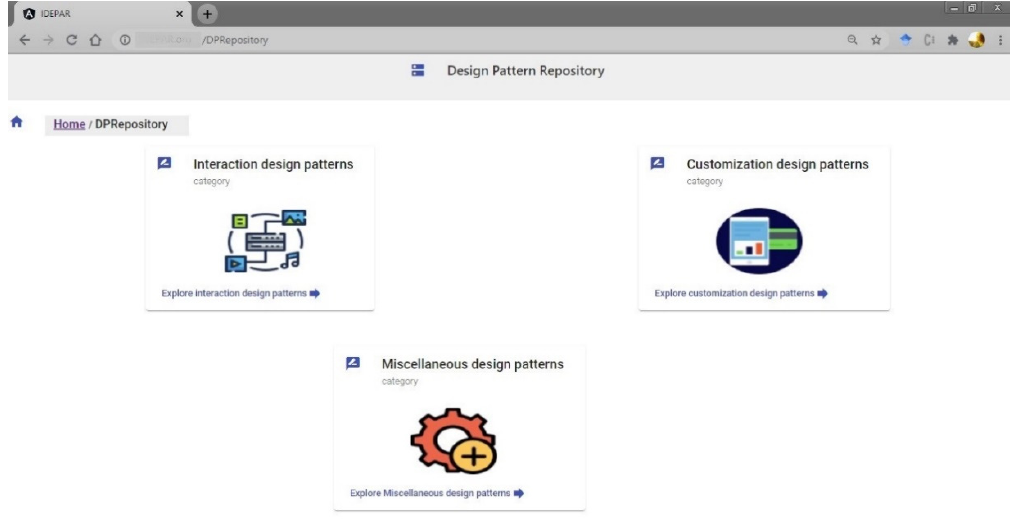
Figure 13. Design pattern repository interface.